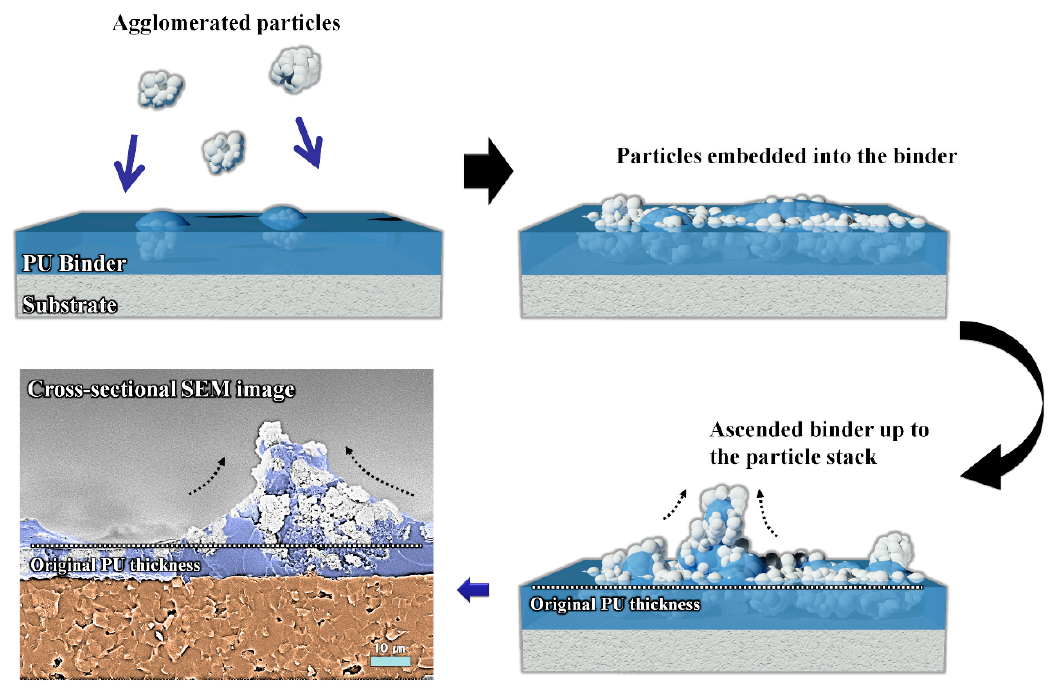
Figure 3. Schematic image of the surface structure assembly mechanism and the fractured SEM image of the sprayed superhydrophobic surface (False color).